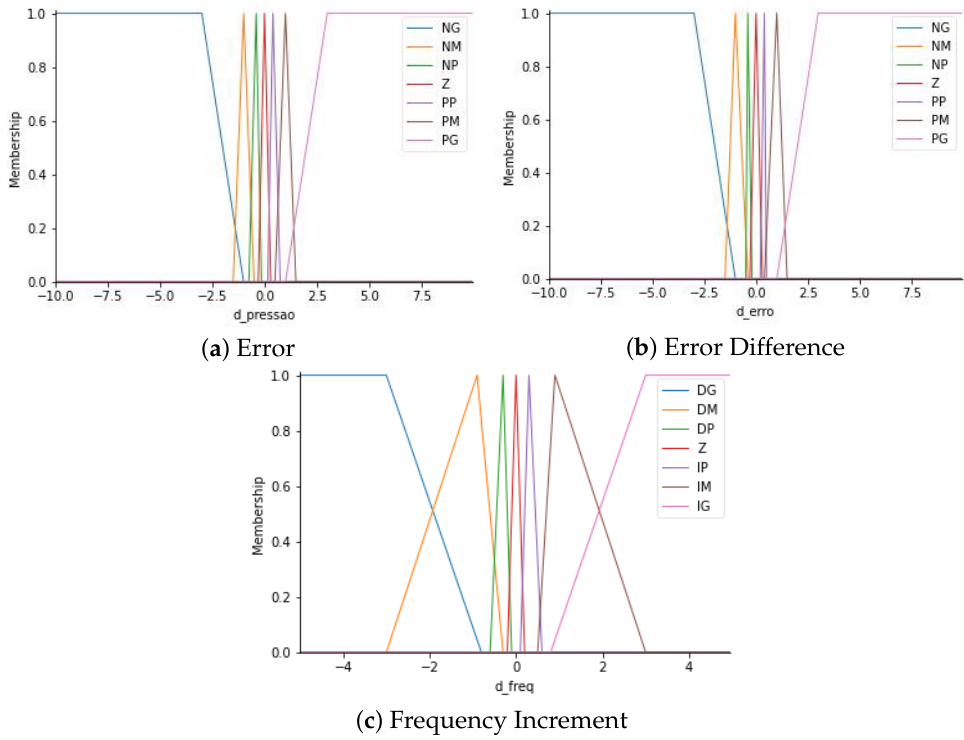
Figure 19. Fuzzy sets. Source: